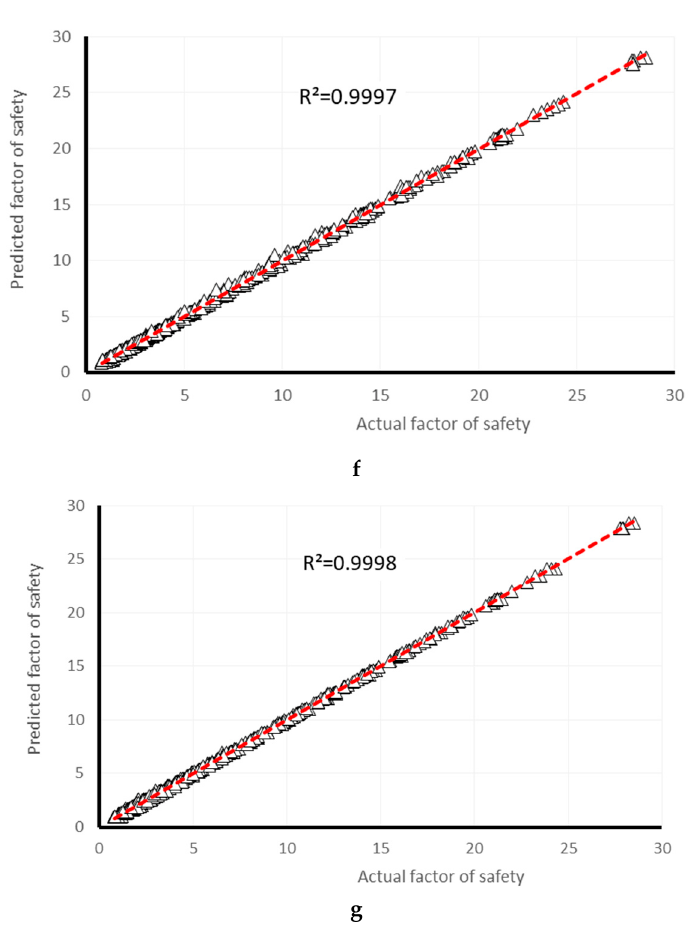
Figure 8. The network result for the training dataset in ( a ) multiple linear regression (MLR), ( b ) multi-layer perceptron (MLP), ( c ) radial basis function regression (RBFR), ( d ) improved support vector machine using sequential minimal optimization algorithm (SMO-SVM), ( e ) lazy k-nearest neighbor (IBK), ( f ) random forest (RF), and ( g ) random tree (RT).